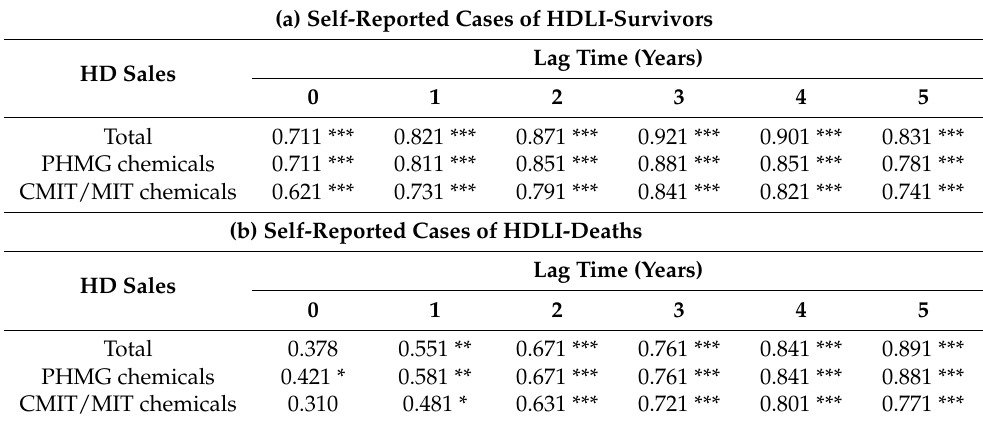
Table 5. Spearman’s rank correlation coefficient between self-reported HDLI cases and annual HD